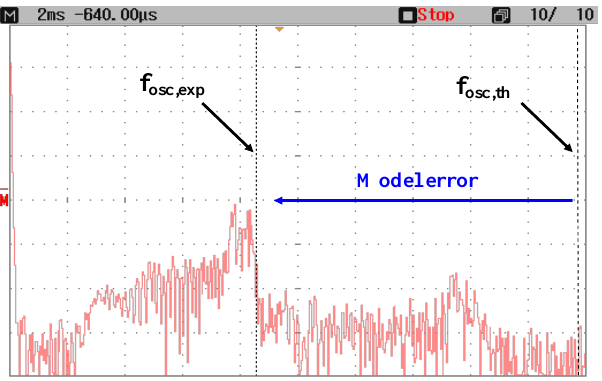
Figure 5. Spectrum of the current input of a single-phase Vienna converter ( 𝑓 𝑜 = 49,25𝑘𝐻𝑧 , ξ = 1).